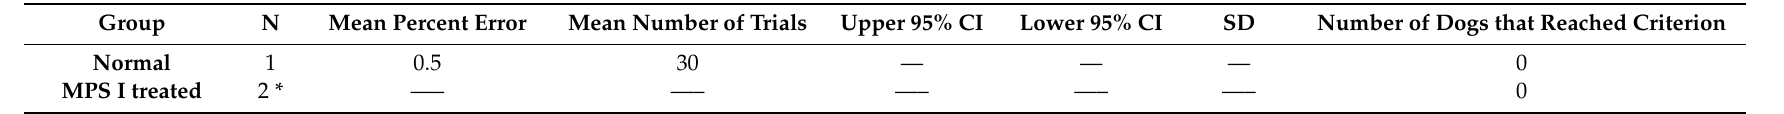
Table 8. DNMP descriptive statistics by group for 60-s delay. This includes the number of dogs tested (N) from each group, mean (real) percent error of each group, mean (real) number of trials performed by each group, 95% confidence interval, standard deviation, and number of dogs from each group that reached the criterion at the 60-s delay.